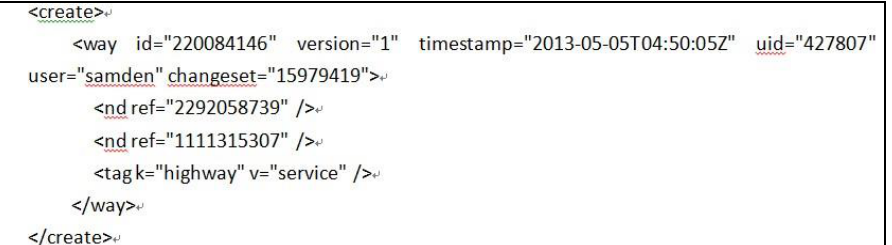
Figure 2. OSM diff file format using “create” section as an example